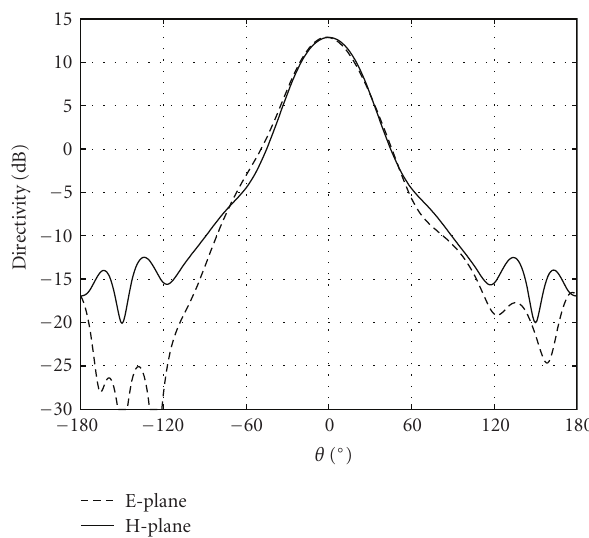
Figure 5: Selectivity of the resonator for normal incidence and various resonant height values.